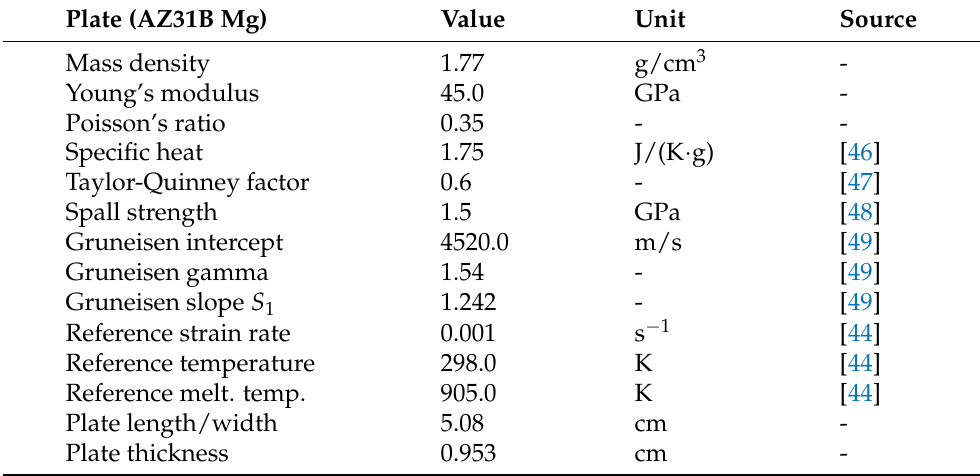
Table 2. Fixed system parameters of the plate used in the ballistic problem.